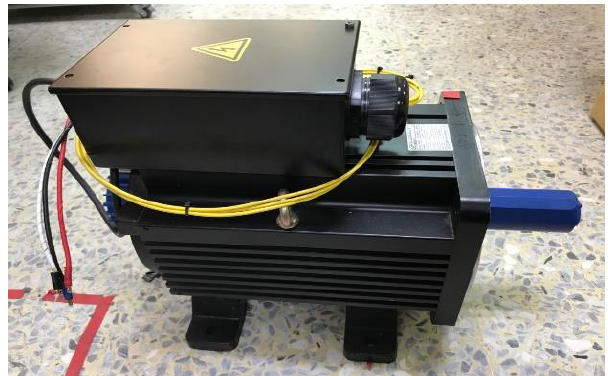
Figure 10. PMSM used in the experimental electric vehicle.